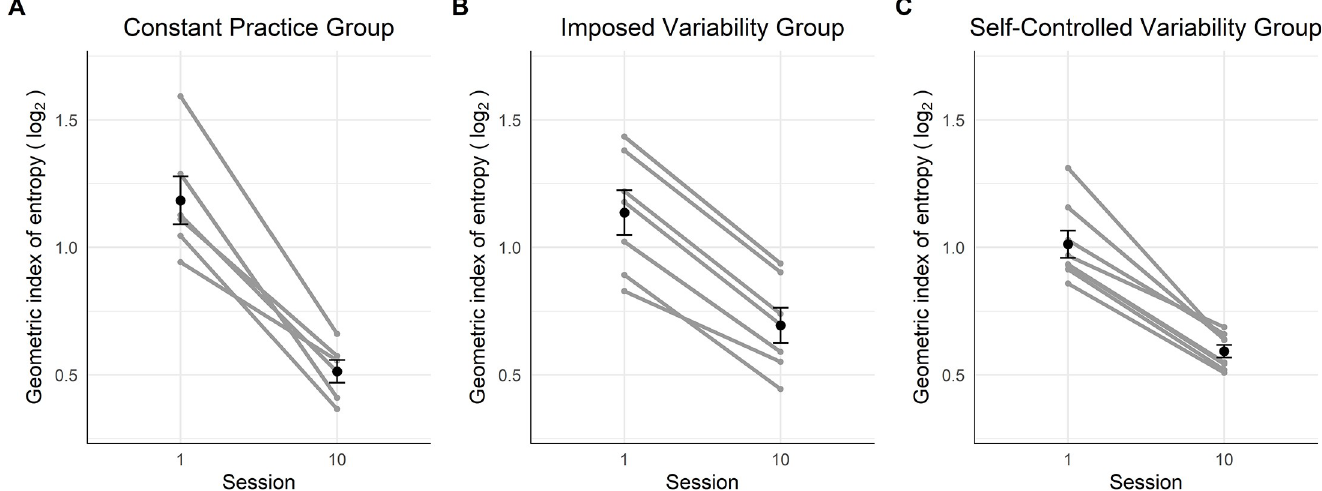
Fig 2. Dynamics of the climbing fluency on the first and last session of the protocol for the three groups. The black points represent the sessions mean and the error bars their standard error. The grey points and lines represent each participant’s dynamics.